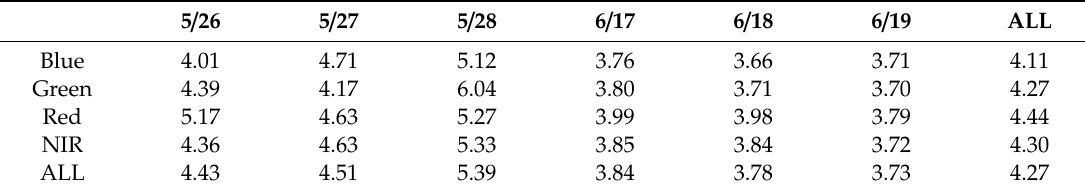
Table 12. Total uncertainty (unit: